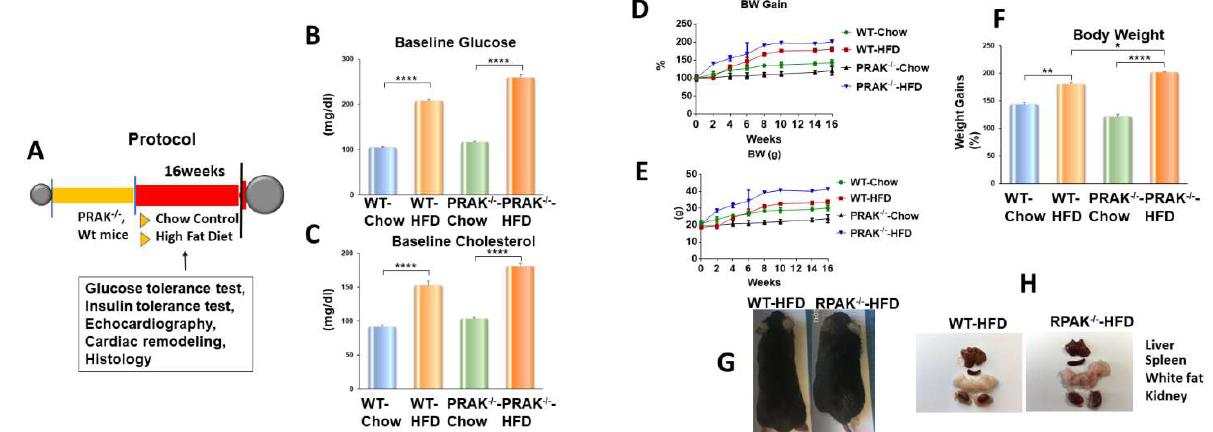
Figure 1. PRAK deletion enhances diet-induced metabolic syndrome in obese mice. ( A ) Schemas of animal experimentation in high-fat diet (HFD) versus chow control diet in both wild-type (Wt) and PRAK −/− mice; ( B , C ) Total blood cholesterol and glucose concentration of mice fed with standard chow or HFD after 16 weeks; ( D – F ) Body weight gain of mice exposed to chow food and a high fat diet in wild type and PRAK −/− mice; ( G , H ) Mouse and organs. Data are shown as means ± SEM * p < 0.05, ** p < 0.01; **** p < 0.0001 ( n = 5/each group).